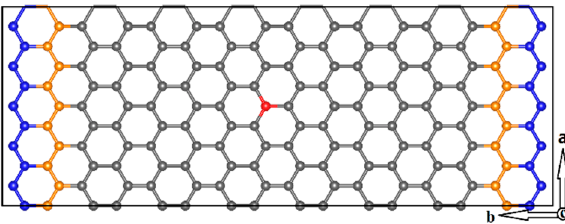
Figure 1. Schematic model of AIMD simulations based on SBC. The two-dimensional periodic graphene sheet includes 160 C atoms. The orange C atoms are Langevin atoms that experience friction and random forces, and the blue atoms are fixed; the atoms of these two parts oscillate around their equilibrium positions. All other atoms (grey and red atoms) correspond to Newtonian atoms, which are free to move according to Newton’s law of motion. The positions of Newtonian atoms constitute the atom implantation region; presumably, the perpendicular collision can occur between the incident Ga/Ge/As atoms and the red C atom in graphene lattice.